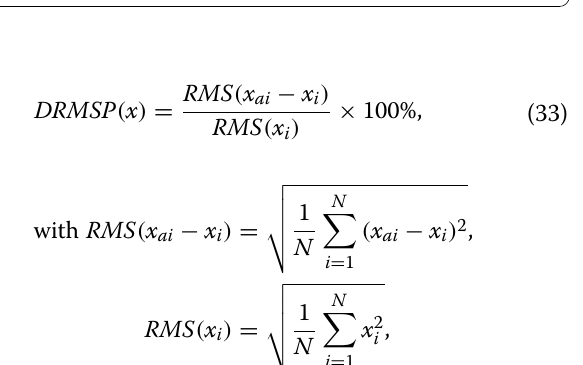
where x ai represents the output of the moving platform in real condition, x i denotes the output of the moving platform in ideal condition. RMS ( x ai − x i ) represents the root mean square error of the output of the moving plat- form in real condition. RMS ( x i ) represents the root mean square error of the output of the moving platform in ideal condition. N is the simulated sample size.